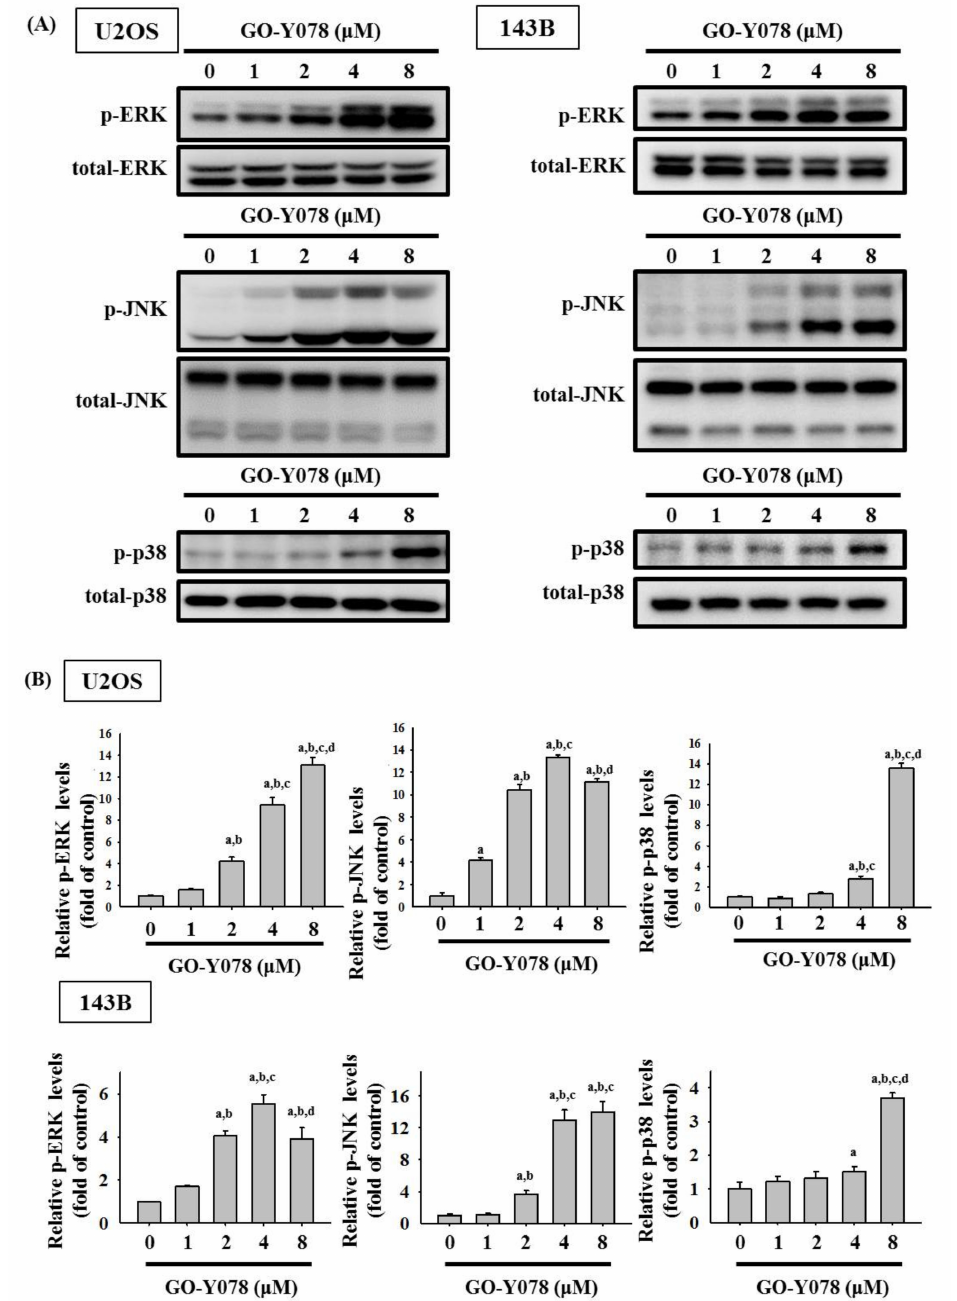
Figure 6. Effects of GO-Y078 on the phosphorylation of ERK, JNK, and p38 in U2OS and 143B cells. ( A ) Expressions of ERK1/2, JNK 1/2, and p38, as well as their phosphorylation after various concentrations (1, 2, 4, and 8 µ M) of GO-Y078 treatment for 24 h in U2OS and 143B cells, were measured through Western blot analysis. ( B ) Next, they were subjected to quantitative analysis. Results are shown as mean ± S.D.; n = 3. ANOVA analysis with Tukey’s posteriori comparison was used. U2OS: p-ERK/ERK: F = 370.856, p < 0.001; p-JNK/JNK: F = 872.068, p < 0.001; p-p38/p38: F = 1181.680, p < 0.001. 143B: p-ERK/ERK: F = 2465.987, p < 0.001; p-JNK/JNK: F = 100.843, p < 0.001; p-p38/p38: F = 120.566, p < 0.001. a Significantly different, p < 0.05, when compared to control. b Significantly different, p < 0.05, when compared to 1 µ M. c Significantly different, p < 0.05, when compared to 2 µ M. d Significantly different, p < 0.05, when compared to 4 µ